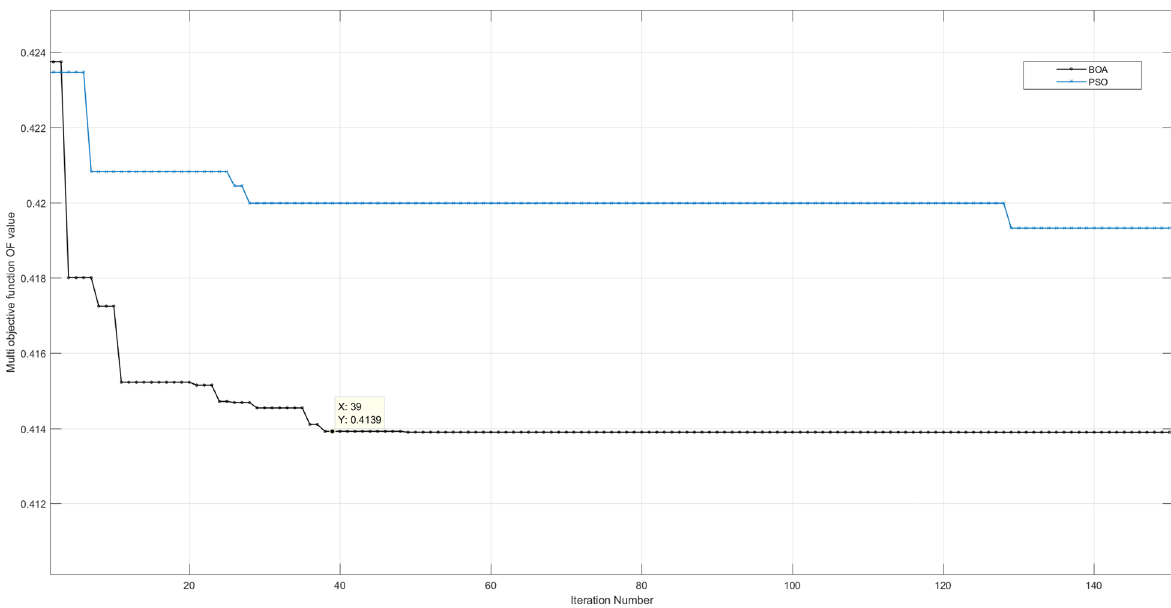
Fig. 8 Convergence graphs of BO and PSO algorithms for optimal placement of DGs at